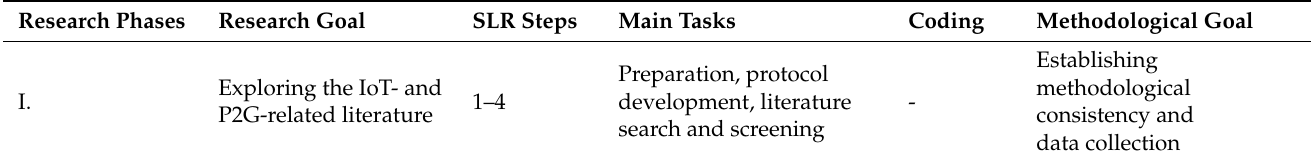
Table 2. Summary of the data collection and analysis process (own